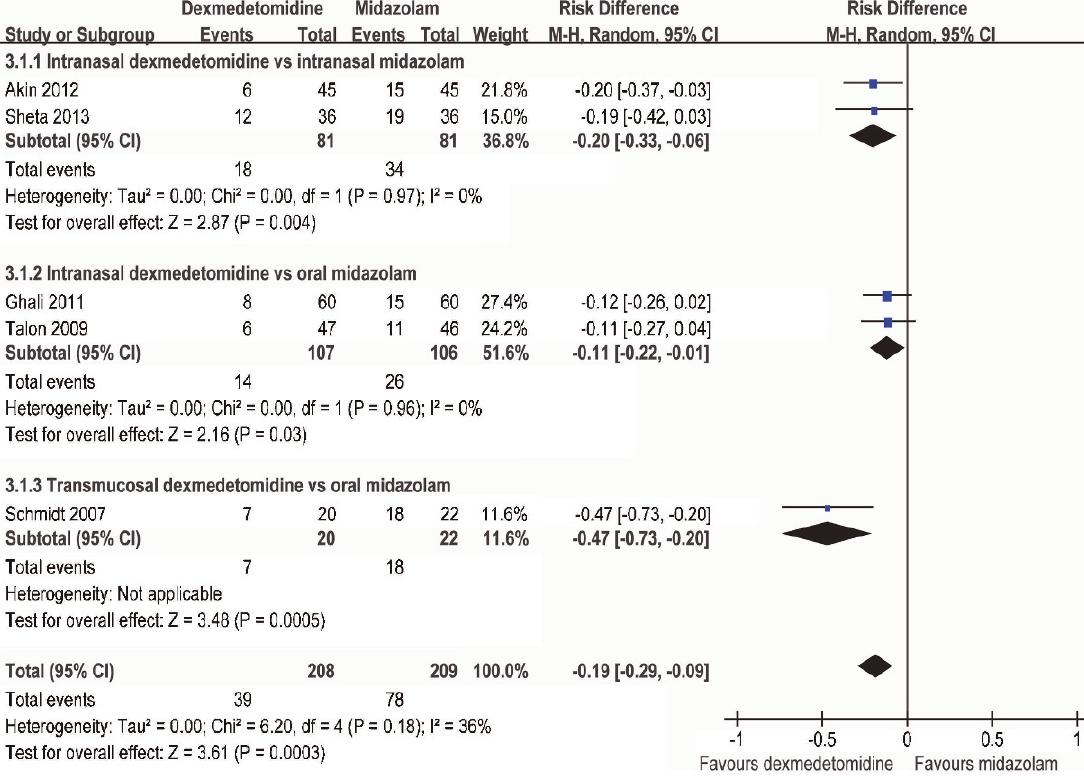
Figure 4 - Meta-analysis of postoperative rescue analgesia in children treated with dexmedetomidine vs .